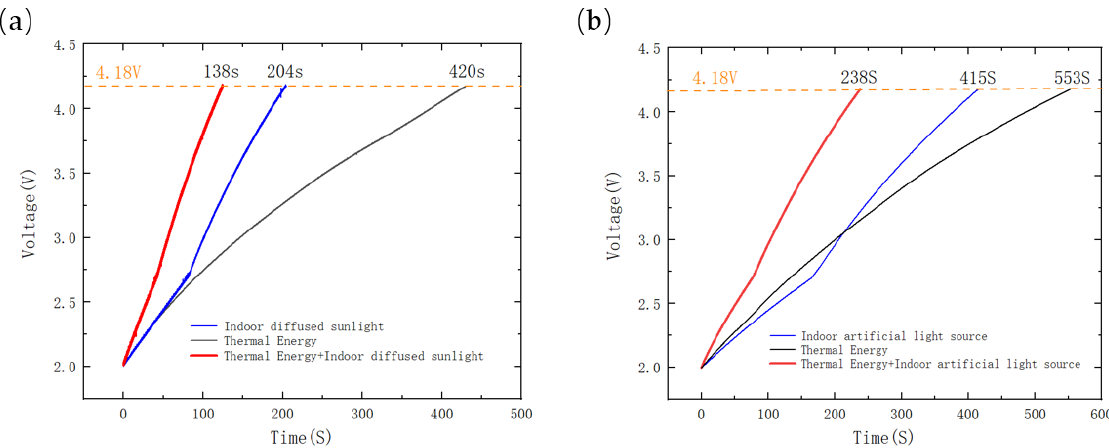
Figure 14. ( a ) Indoor scattered natural light test (daytime); ( b ) fluorescent light test